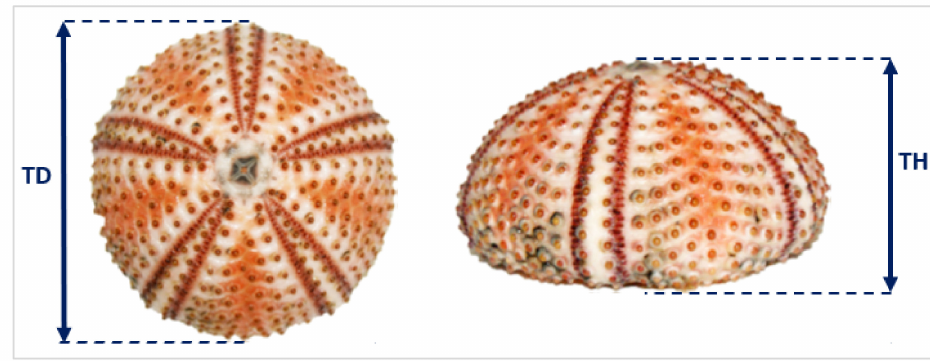
Figure 2. Measured test dimensions: test diameter (TD) and test height